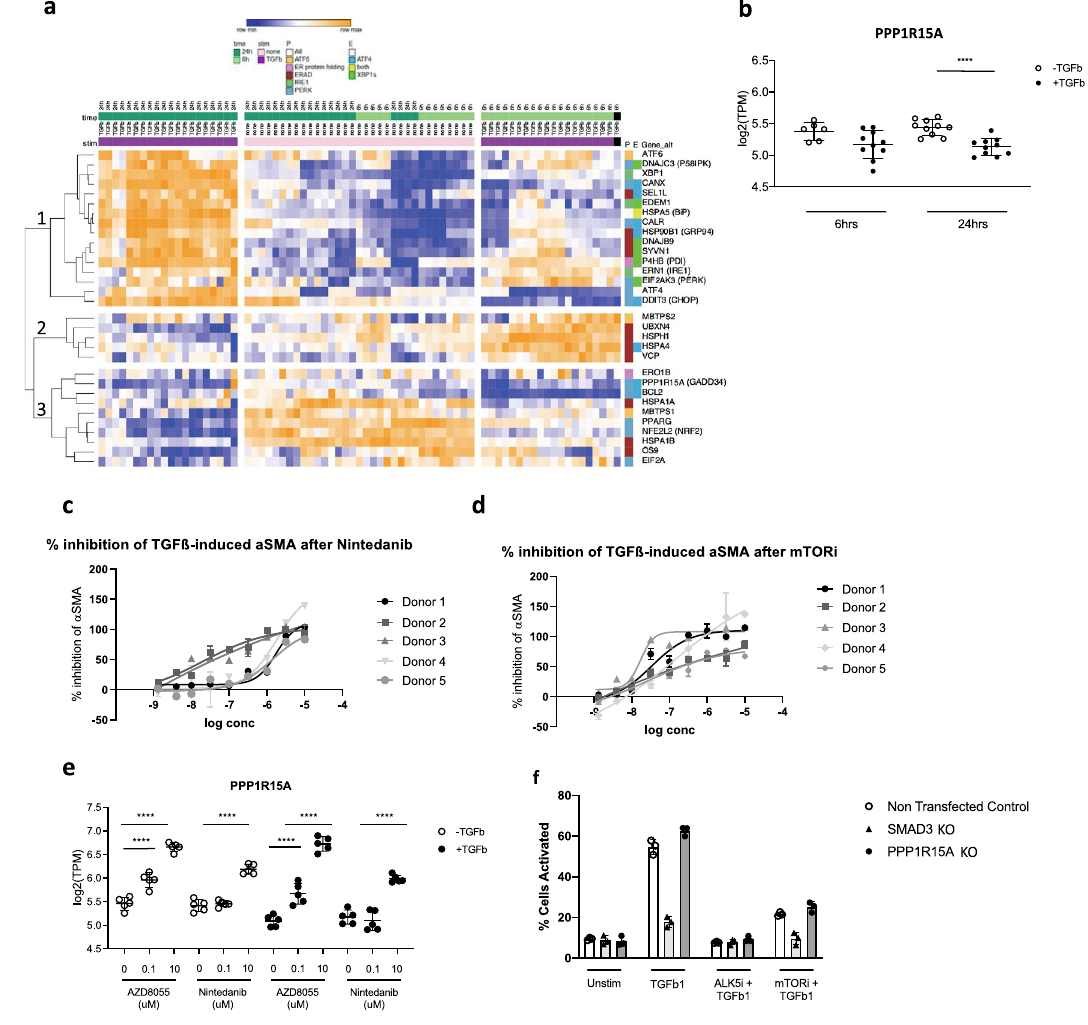
Figure 3. Modulation of TGFβ1-mediated UPR pathway and fibroblast activation. ( a ) Heatmap of gene expression [log2(TPM)] of the UPR genes from Table S1 for IPF fibroblasts (5 donors, 3–5 replicates) treated with TGFβ1 (0.123 ng/ml) for 6 h or 24 h. The genes are further colour coded into pathway (P) and expression regulators (E) according to Table S1. The genes fall into three groups based on their expression: those genes whose expression is repressed by TGFβ1 at either or both times including PPP1R15A (bottom panel); those genes whose expression is only transiently up-regulated by TGFβ at 6 h (middle panel); and those genes including DDIT3 and ATF4 whose expression is up-regulated by TGFβ at 24 h (top panel). This last group of genes consist of all genes regulated by XBP1 and the majority of those regulated by ATF4. ( b ) Expression plots of PPP1R15A ( b ) following TGFβ1 treatment at both 6 h and 24 h. ( c , d ) Dose–response curves for IPF fibroblasts treated with TGFβ1 (0.123 ng/ml) in the presence or absence of different concentrations of nintedanib ( c ) or mTOR inhibitor (AZD8055) ( d ) for 24 h. The expression of α-SMA was determined by immunofluorescence. ( e ) Gene expression of PPP1R15A in IPF fibroblasts in the presence or absence of TGFβ1 plus nintedanib or AZD8055 for 24 h. n = 5 IPF donor cell lines with each dot representing a different donor in each condition and data is expressed as mean ± s.e.m. ( f ) TGFβ-induced myofibroblast activation was quantified between KOs and wild-type (non-transfected control: NTC) cells. Cells in starvation conditions were incubated with positive control compounds (mTOR inhibitor and ALK5 inhibitor) (3 µM) for 1 h before treatment with TGFβ (0.125 ng/ml) for 24 h. Unstimulated cells were treated with 0.1% (v/v) DMSO for normalisation. SMAD3 KO was used as a positive control for inhibition of TGFβ-induced myofibroblast activation. Myofibroblast activation was measured by immunofluorescence of αSMA and represented as percent cell activation, based on Columbus linear classifier algorithms using intensity, texture and morphology features. FDR adjusted P-values are show on plots where significant, ** P < 0.01, **** P <